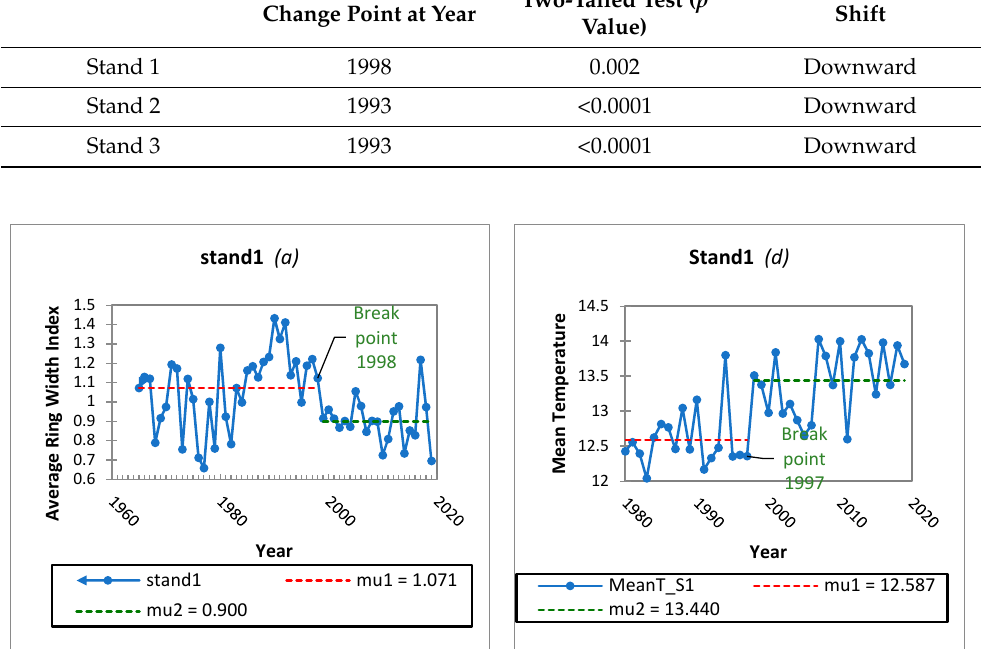
Table 3. Results of the Pettitt homogeneity test and the Statistically significant change years regard- ing ARWI. Two-Tailed Test ( p Change Point at Year Shift Value) Stand 1 1998 0.002 Downward Stand 2 1993 <0.0001 Downward Stand 3 1993 <0.0001 Downward